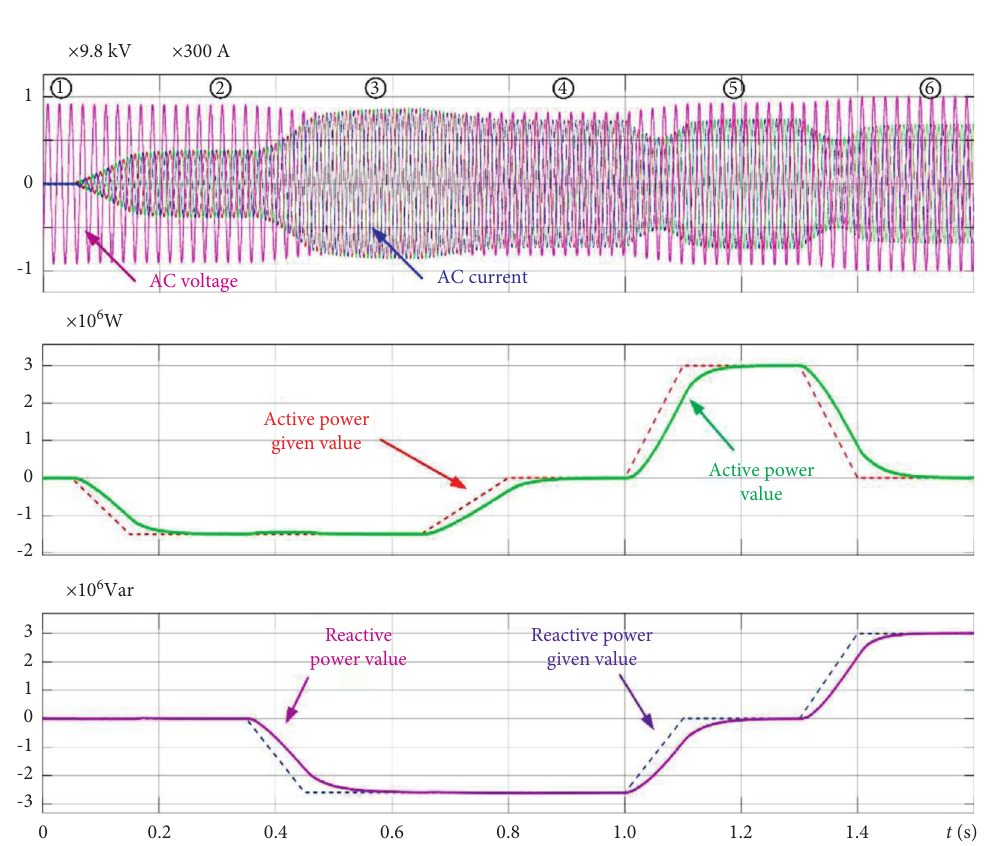
Figure 9: Simulation results of power layer energy forward and reverse